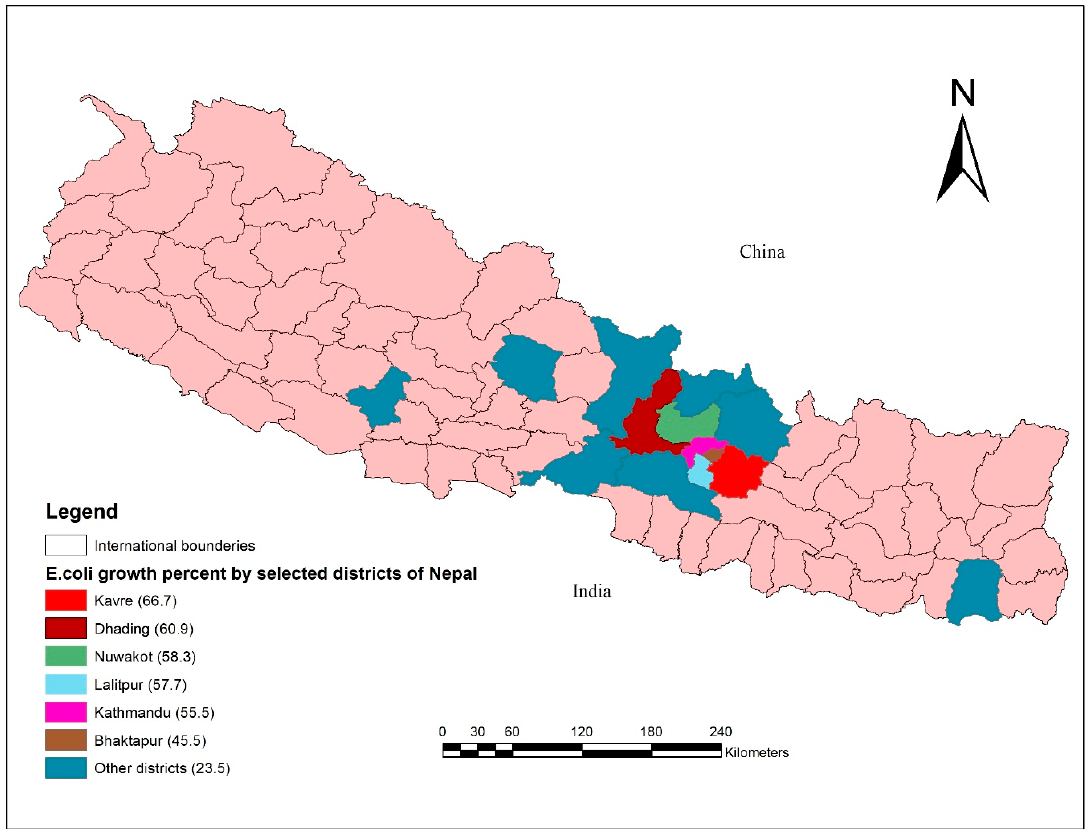
Figure 3. Isolation of E. coli in poultry liver samples collected in different districts of Nepal. Table 1. Growth of E. coli in the poultry liver samples according to age of dead poultry, flock size and type of